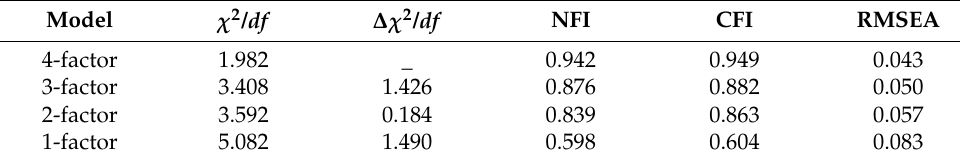
Table 4. Model fit comparison, alternate vs. hypothesized